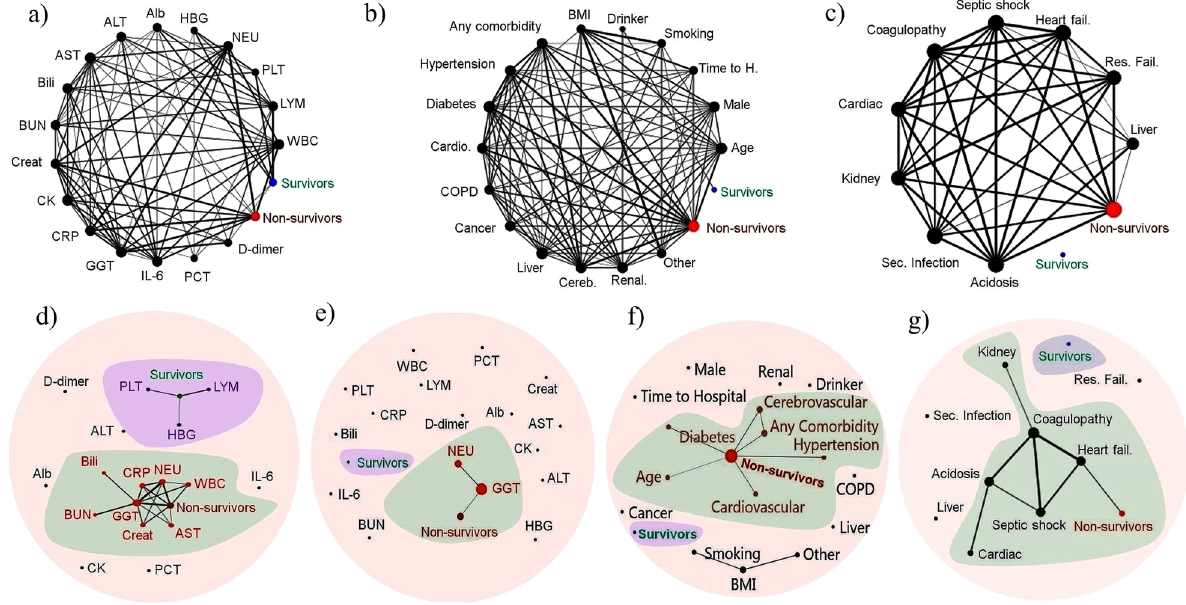
Figure 2. Correlation-based network analysis. The Pearson correlation threshold of 50% was used to show the network of all variables ( a – c ). More precisely, the Pearson correlation thresholds of 72% and 93% ( d , e ) were respectively selected to define the connection between survivors, non-survivors and blood parameters. The Pearson correlation thresholds of 79% and 97% were respectively chosen to assess the relationship between survivors, non-survivors and ( f ) risk factors or ( g ) complications. Circles of the network indicate the blood parameters ( a , d , e ), risk factors ( b , f ) and complications ( c , g ). The size of the node reflects the degree of connectivity of the node and the edges display the relationship between the two variables. The thicker edges reveal higher correlations between variables. Nodes with more links are close to each other. Network analysis and visualization was carried out using PAST and Fruchterman-Reingold algorithm or Circular algorithm as a force-directed layout algorithm. Abbreviations in panels ( a ), ( d ), and ( e ): Alb, albumin; HBG, hemoglobin; NEU, neutrophil; PLT, platelet; LYM, lymphocyte; WBC, white blood cells, PCT, procalcitonin; GGT, gamma- glutamyl transferase; CRP, C-reactive protein, CK, creatine kinase; Creat: creatinine, BUN, blood urea nitrogen; Bili, total bilirubin; AST, aspartate aminotransferase; ALT, alanine aminotransferase. Abbreviations in panels ( b ) and ( f ): BMI, body mass index; Time to H, time from symptoms appearance to hospitalization; Renal, renal disease; Cereb, cerebrovascular disease; Liver, liver disease; COPD, chronic obstructive pulmonary disease; Cardio, cardiovascular disease. Abbreviations in panels ( c ) and ( g ): Fail, failure; Res, respiratory; Liver, liver dysfunction; Sec, secondary; Kidney, acute kidney injury; Cardiac, acute kidney